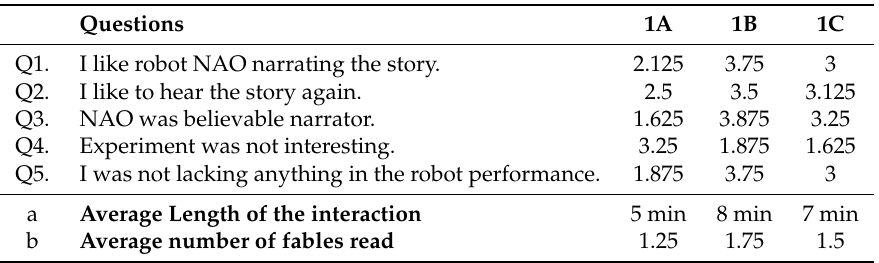
Table 16. Results from the experiment